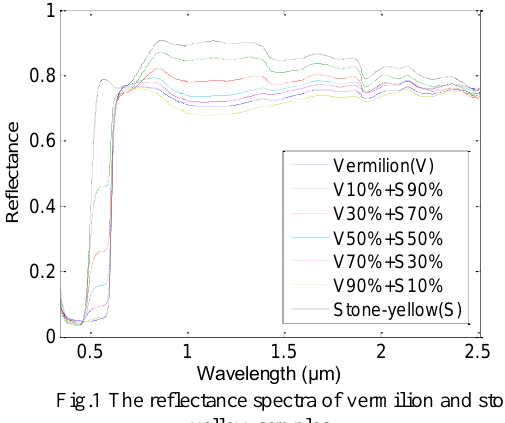
Fig.1 The reflectance spectra of vermilion and stone yellow samples